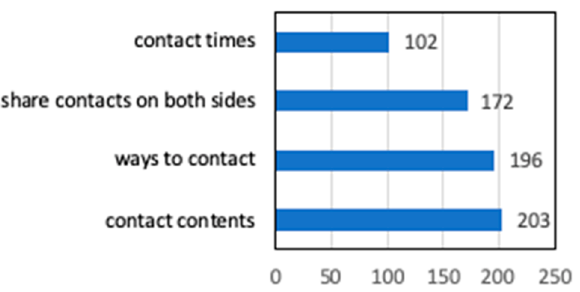
Figure 14. Information sharing with the disaster response headquarters (multiple answers) (Multiple answers, total number of responses 770, total number of respondents: 417, unit: number of responses).